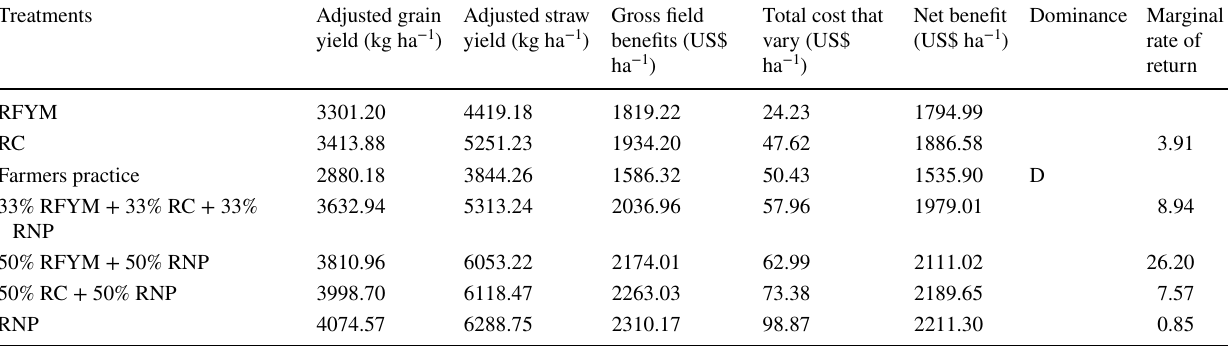
Table 7 Economic analysis for the use of integrated organic and mineral amendments on malting barley at Lemu-Bilbilo district in southeastern Ethiopian highlands